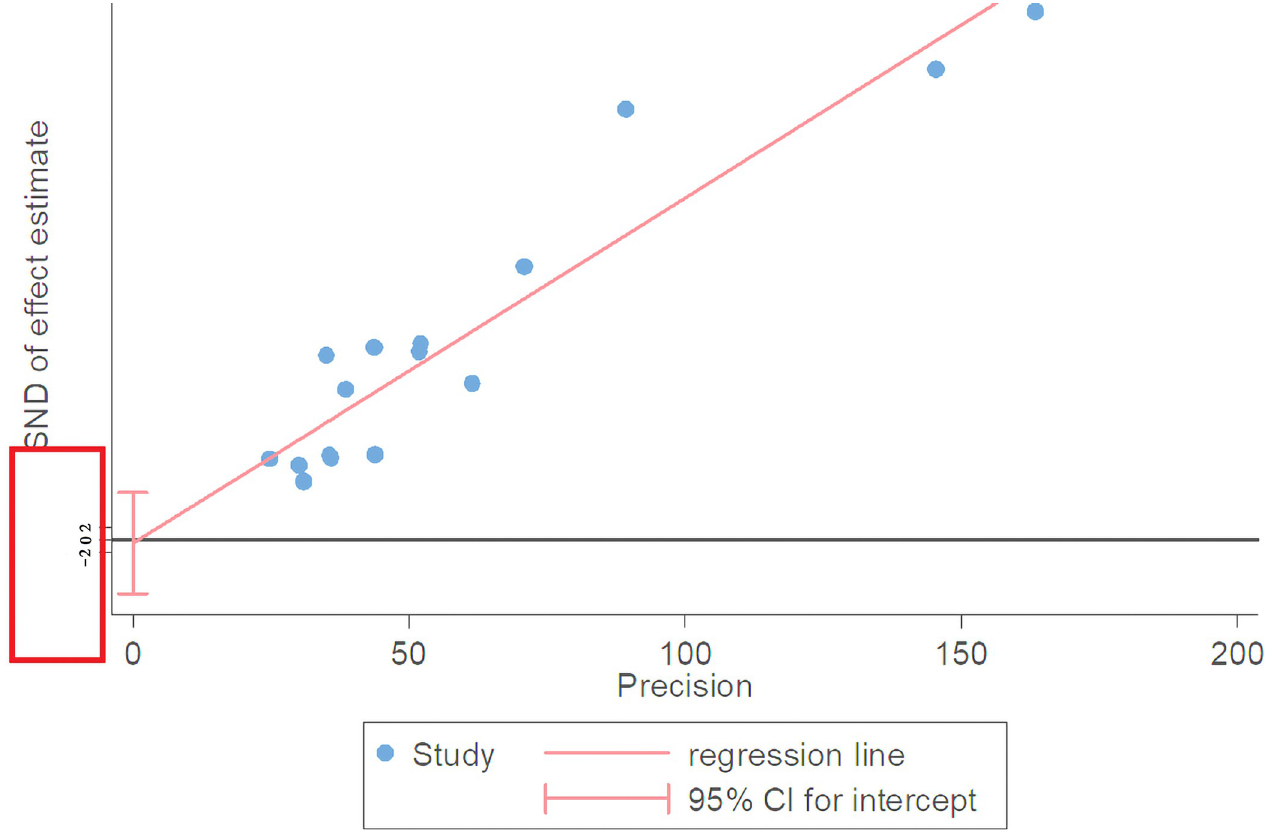
Fig 6. Egger diagram to investigate the bias in dissemination of results using the meta bias command for a meta-analysis of vaccine prevalence in pregnant women.